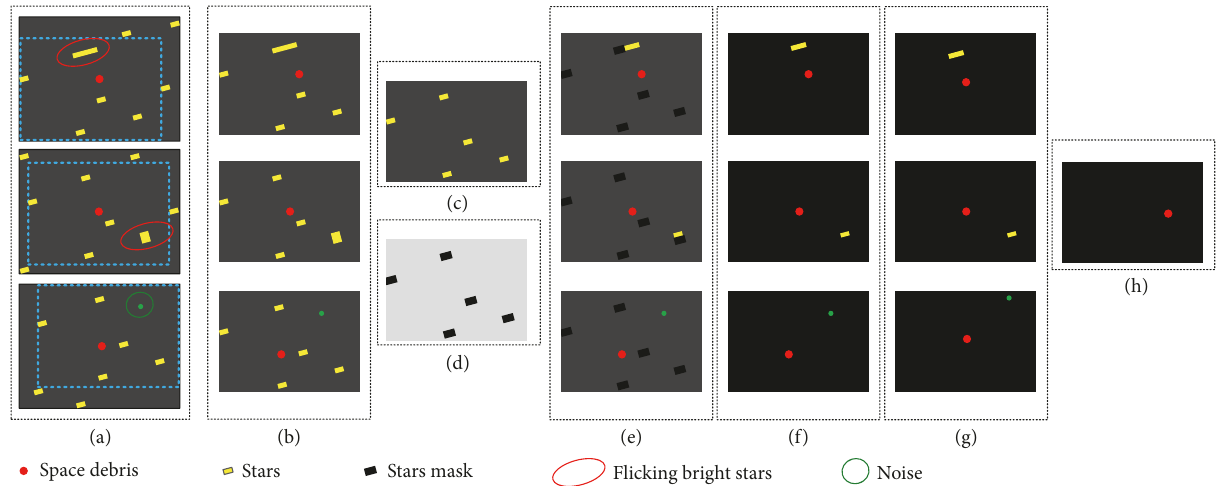
Figure 4: Step diagrams of image processing. (a) Consecutive raw frames with flicker stars and noise. (b) Frames panned to match stars. (c) Median frame of (b). (d) Mask frame. (e) Panned frames masked by mask frame. (f) Frames with candidate objects. (g) Frames panned to original position. (h) Frame after objects